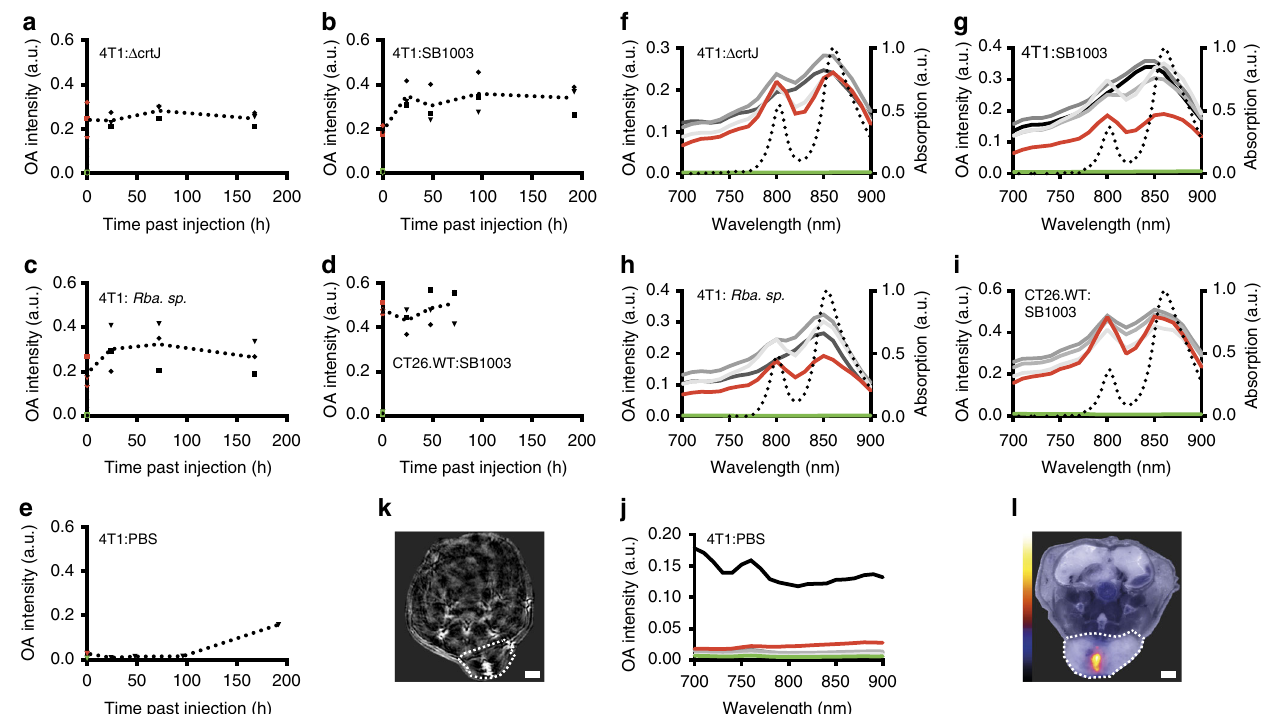
Fig. 1 Characterization of the OA signal and spectra of phototrophic bacteria injected into tumors. a – e OA signal of phototrophic bacteria Rba. capsulatus SB1003 (SB1003), mutant Δ crtJ ( Δ crtJ), and Rba. sphaeroides ( Rba. sp.) injected into 4T1 and CT26.WT tumors. For each strain, data are shown from three mice before injection (green), immediately after injection (red) and at several timepoints after injection (black); dotted line represents the average ( n = 3). The signal was calculated as the sum of the signal intensities at the maximum wavelength of all unmixed pixels in the region of interest summed over all slices. Target spectra for unmixing were the 860-nm absorption peaks of all strains. Data from PBS-injected mice used as a control. f – j Change of the OA spectra of the same mice shown in a - e over time. Shown are the average spectra of all three mice per strain and timepoint. Data from before injection are shown in green; immediately after in red and at increasing timepoints as shades of gray (24, 48, 72/96, 168/192 h). The spectrometrically determined absorption spectrum of the injected agent is shown for comparison as a dotted line. k MSOT slice of the mid-section of a 4T1 tumor-bearing mouse at 24 h after injection with Rba. capsulatus Δ crtJ and illuminated at 720 nm. l Cryosection of 4T1 tumor-bearing mouse at terminal timepoint (168 h) after injection with Rba. capsulatus SB1003. Excitation 740/40nm bandpass, emission 850 nm longpass, exposure 10 s, gain 40. The analyzed region of interest (i.e., tumor) is indicated as a dotted line in both images (k, l). Scale bar: 2